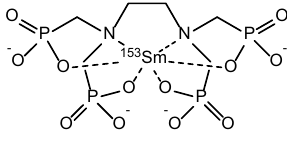
Fig. 6 Molecular Structure of [ 153